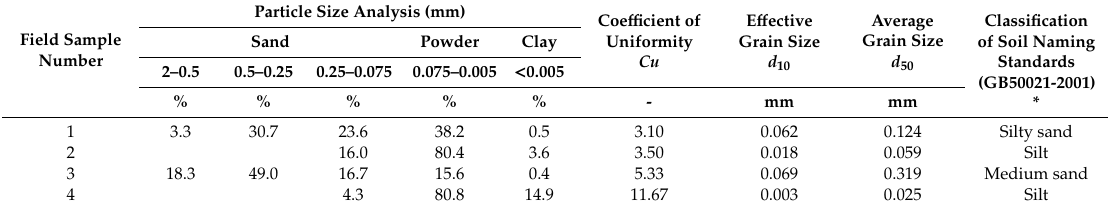
Figure 2. Sampling information of this study and Quaternary Holocene profile of the Yellow River alluvial plain. Table 1. Geotechnical test results of experimental media.